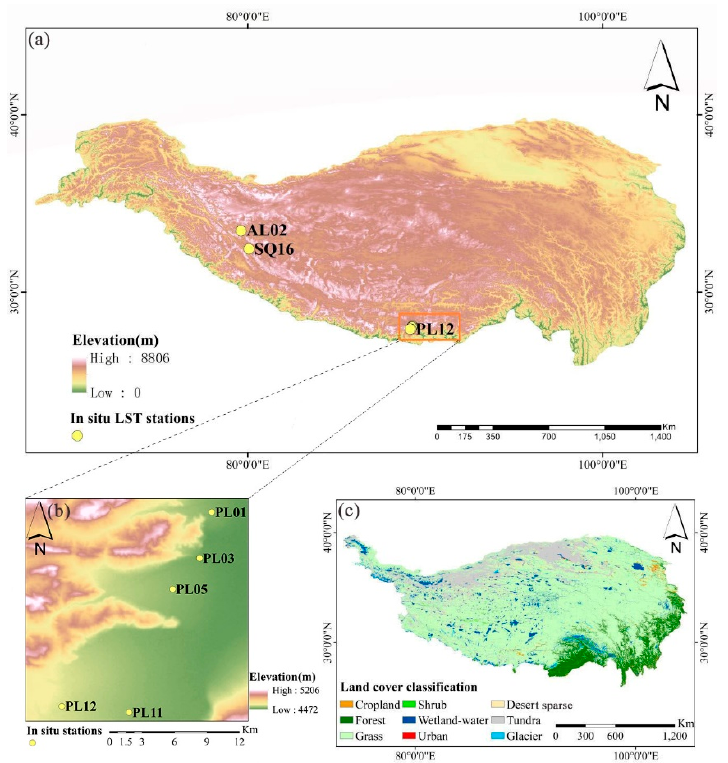
Figure 1. Study area and soil temperature measurement sites. ( a ) DEM data were downloaded from the geospatial data cloud platform of the computer network information center of the Chinese Academy of Sciences. ( b ) AL02, SQ16, PL01, PL03, PL05, PL11, PL12 are the names of soil temperature sites, AL, SQ, PL represent different prefectures. ( c ) Land cover data were downloaded from the national Tibetan Plateau scientific data center.